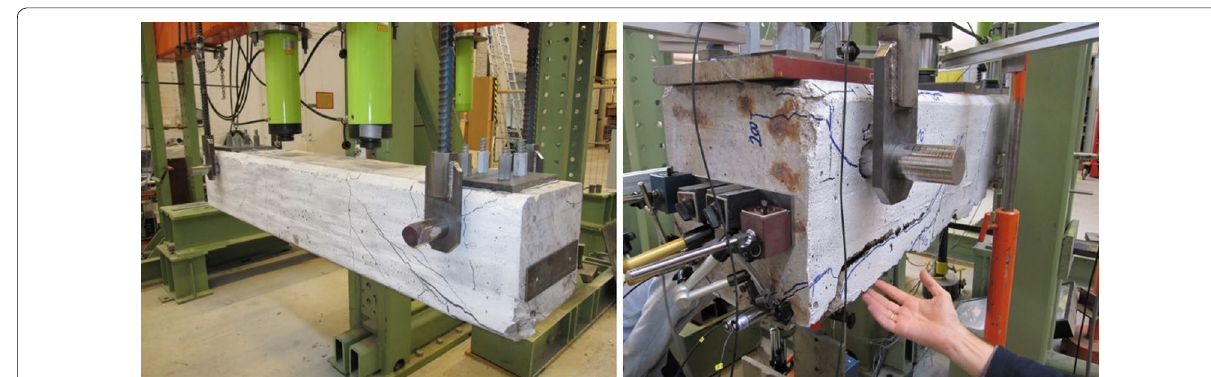
Fig. 4 Pilot tests with improved strengthening method at the suspension holes. Left: specimen without initial damage, after structural testing. Right: specimen with initial corrosion damage including cover spalling, upon